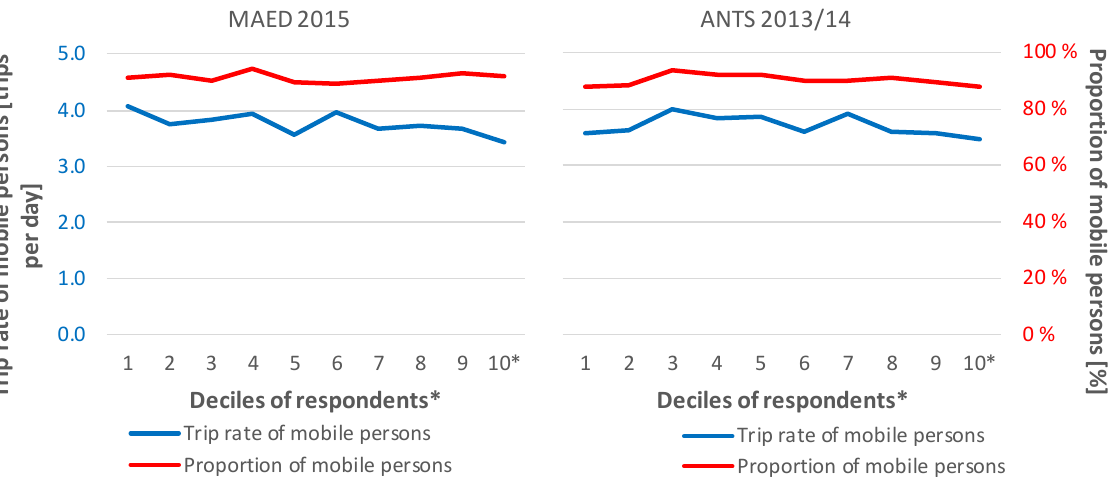
Figure 8. Trip rate and proportion of mobile persons (means) as a function of the speed-of-response. Fatigue as a possible reason for a decreasing trip rate within the MAED-participants’ reporting week was not found. The linear model applied showed that the trip rate is hardly affected by the reporting day (β o = -0.003, p = 0.85). In the following we examine possible reasons for the decreasing trip rate based on the finding from the literature review described in section ‎ 2.2: a. Different socio-demographic groups: ‎ Figure 9 shows the